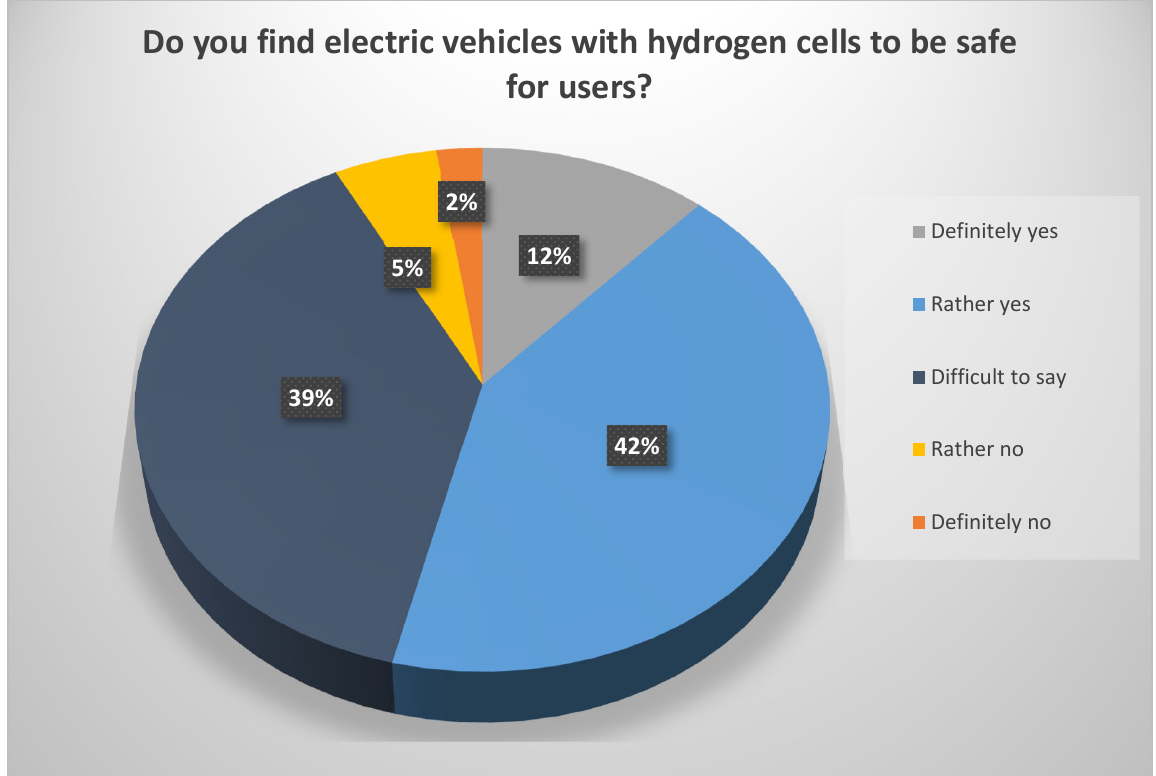
Figure 3. Survey question number 3. Source: own study.